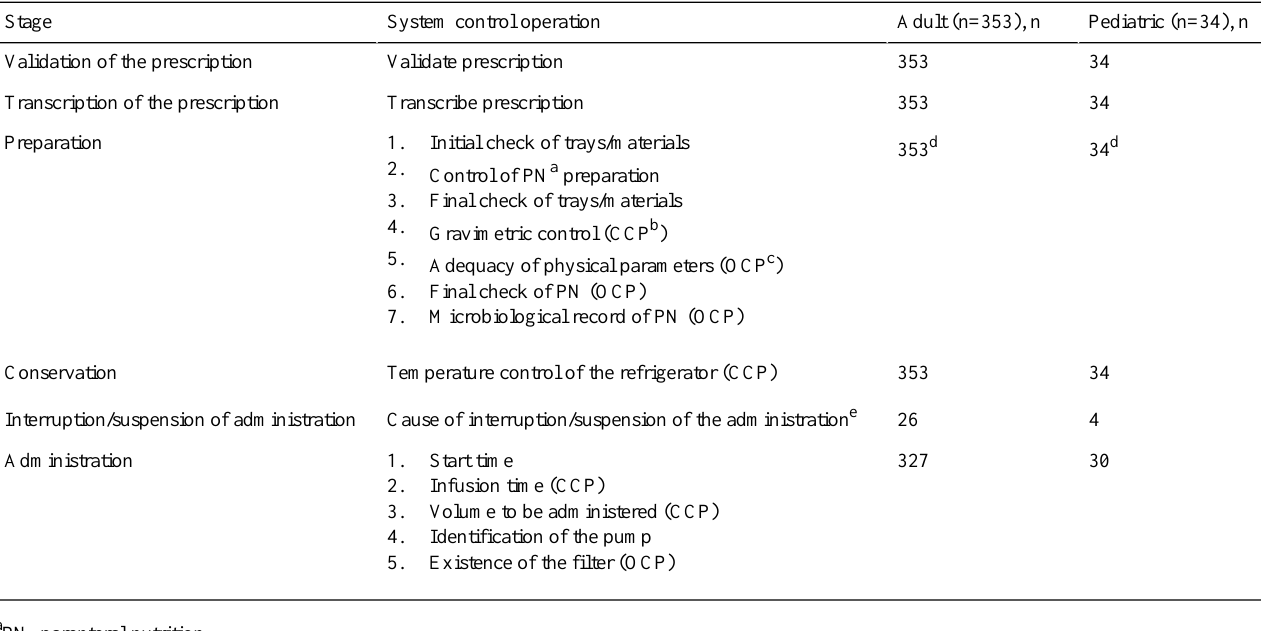
Table 2. Control operations for each stage of the parenteral nutrition management system at Son Espases University